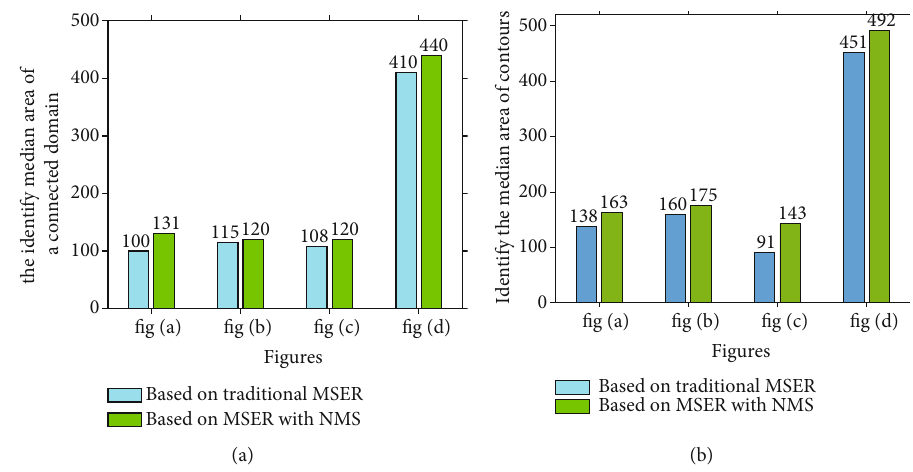
Figure 10: Recognized connected domain area and contour before and after improvement.